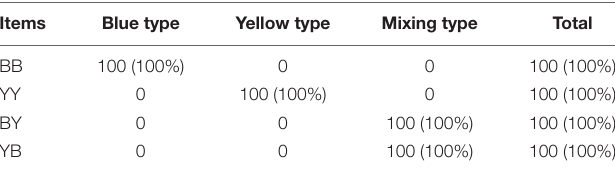
TABLE 5 | Mantle coloration pattern of two strain’s progeny (BB and YY), and their reciprocal hybrids (BY and YB).